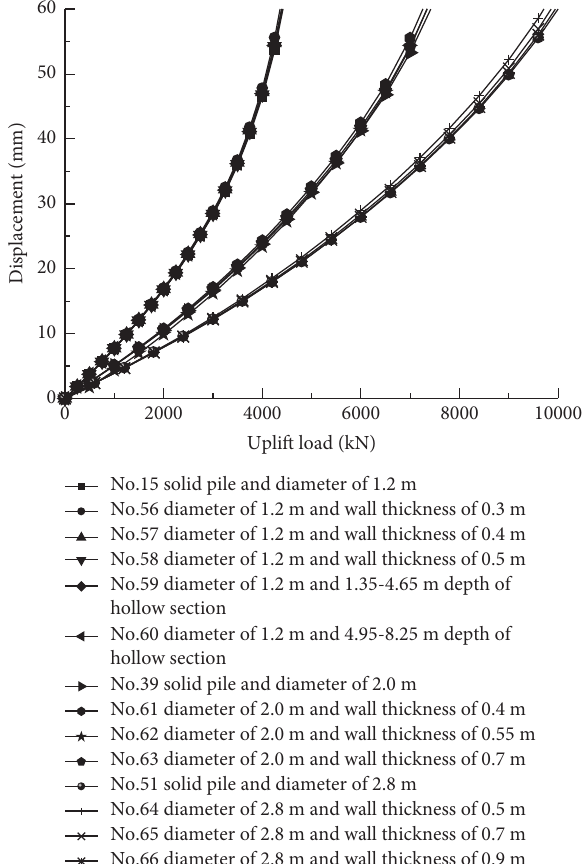
Figure 15: Uplift load displacement of piles with hollow sections.